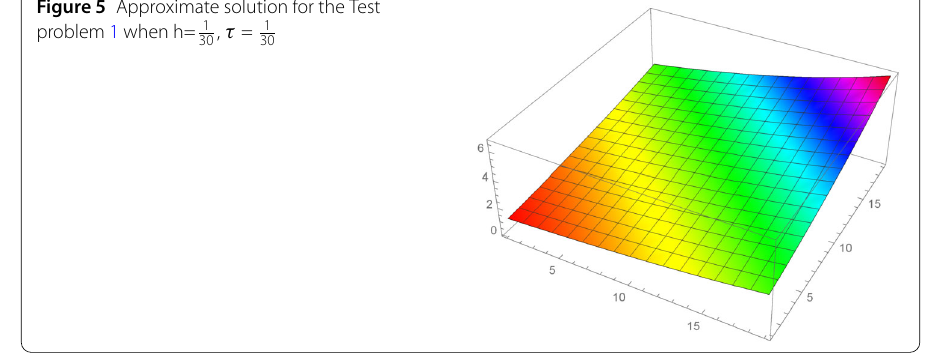
Figure 5 Approximate solution for the Test problem 1 when h= 1